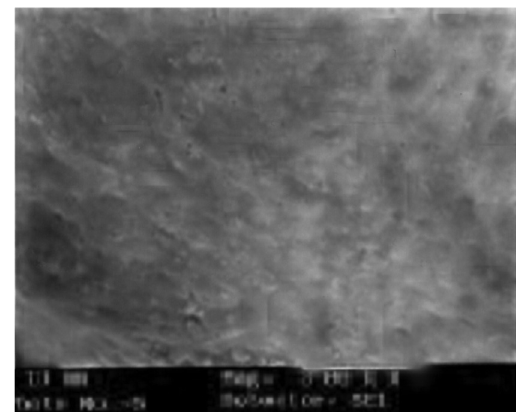
FIGURE 6 - Scanning electron micrograph of stearic acid coated pellets (500X).